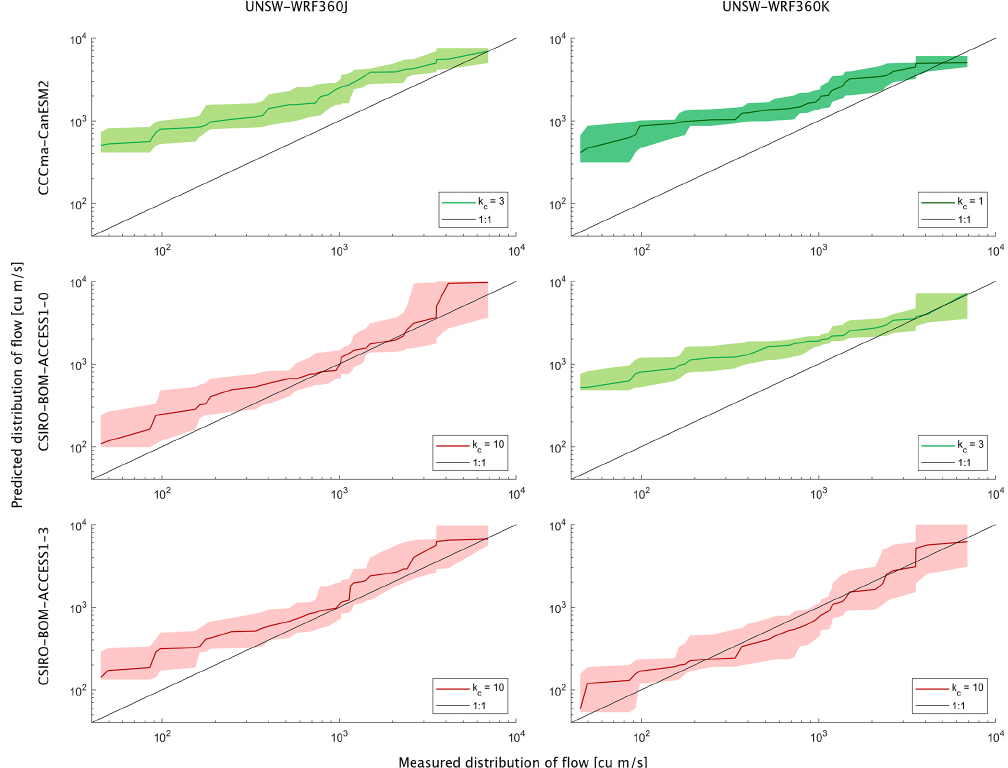
Figure 4. Comparisons between modelled discharge at Gravesend (Fig. 2) with measurements for all global (rows) and regional (columns) climate model combinations. Model discharges includes additional evaporation via local storages ( f = 0 . 0005, h max = 0 . 2m and u = 80mmd − 1 ). Hydrology model parameter m = 0 . 5 for all cases and k c is indicated in each panel. Black lines indicate perfect agreement, solid coloured lines and corresponding shaded regions are mean and 95% confidence of measured distribution when resampled to compare with modelled discharges; different colours indicate different k c